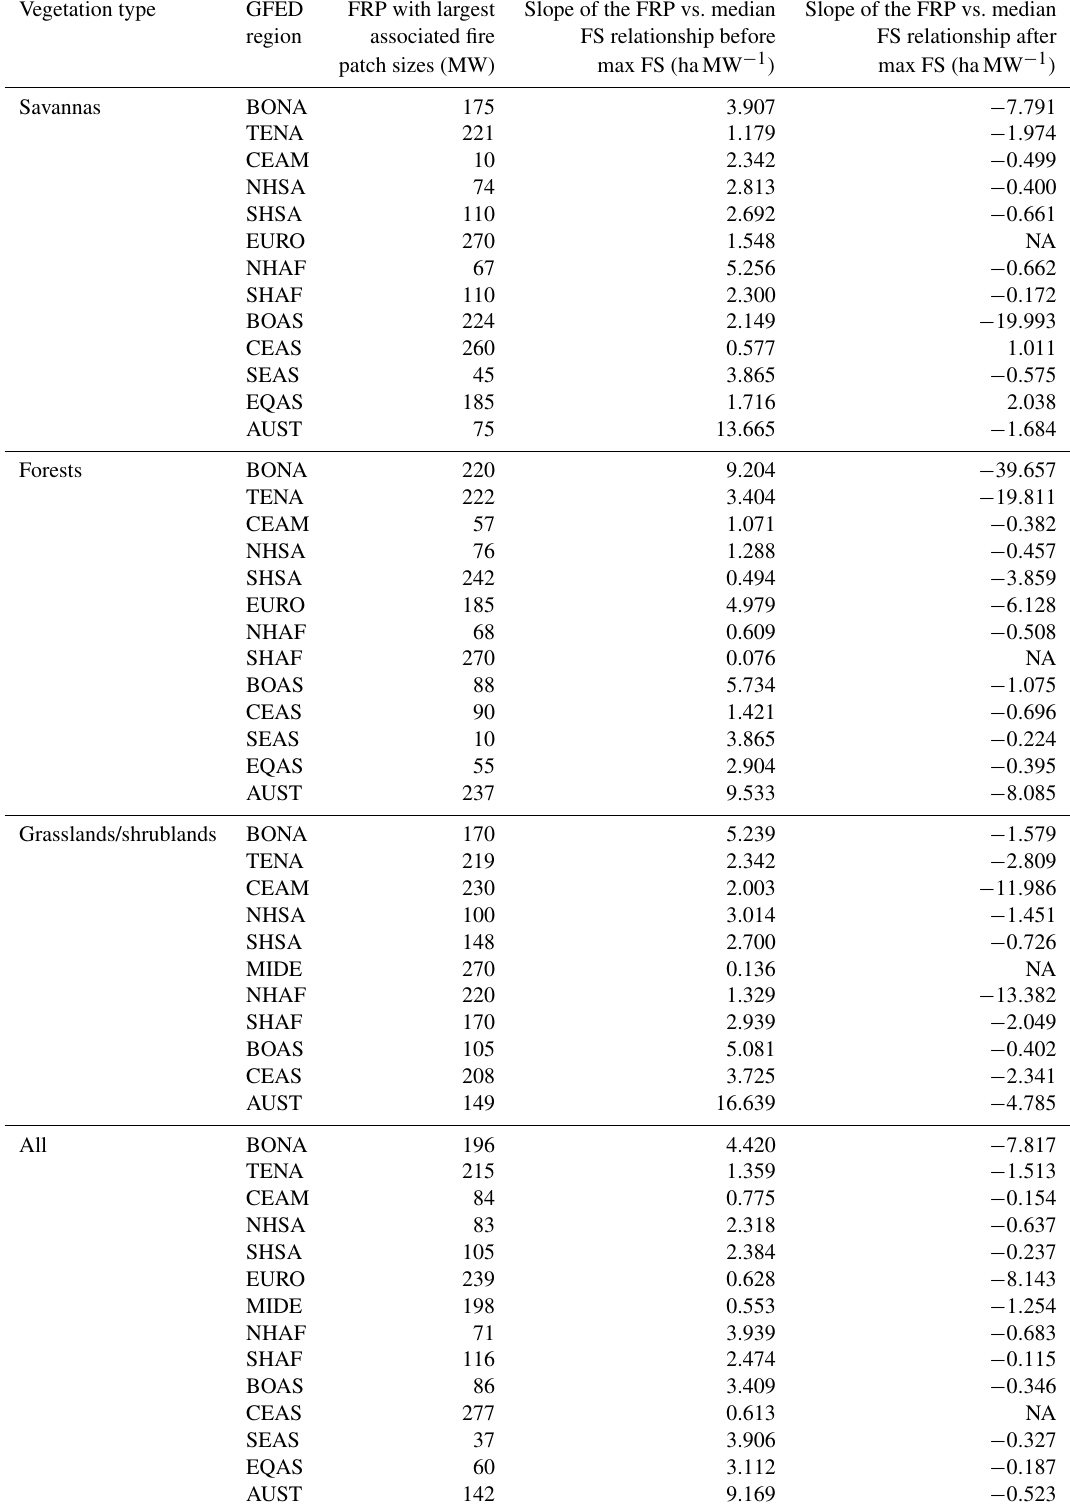
Table 1. Value of the FRP threshold at maximum median FS, and the slope of FS vs. FRP before the threshold value for different GFED regions. Note that the value of the decreasing slope is not always available because there is no FRP bin after the detected maximum FRP. Vegetation